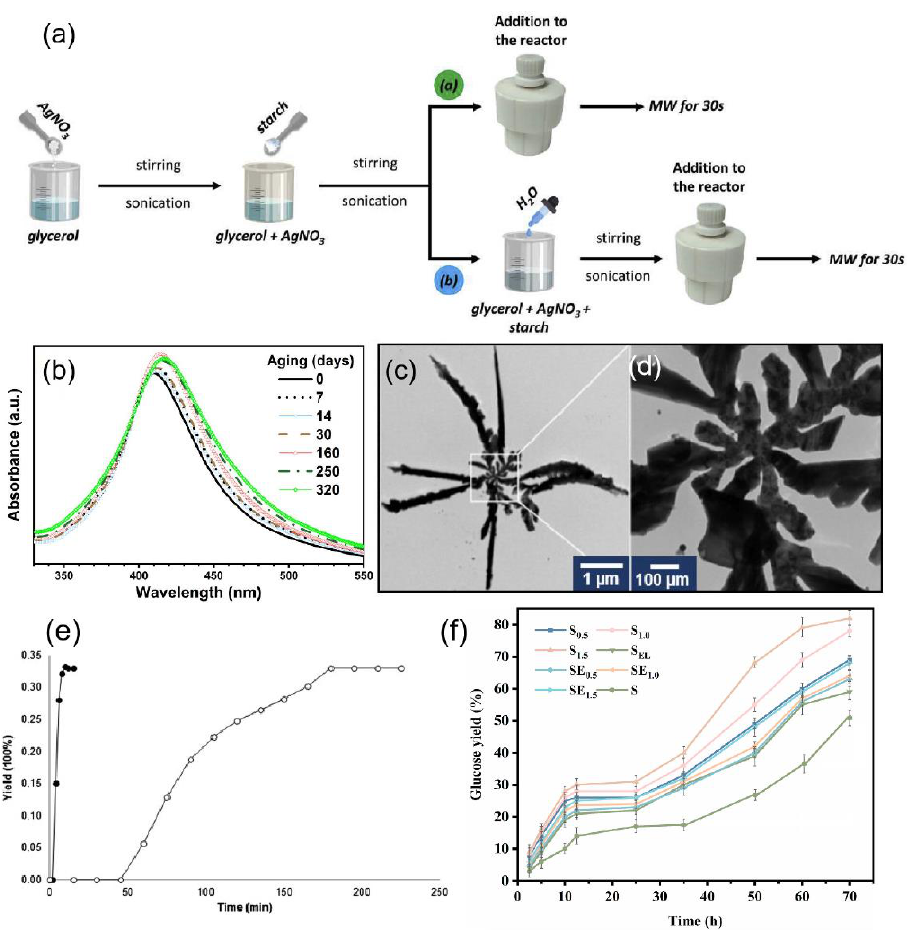
Figure 6. ( a ) Schematic representation for the syntheses of Ag NPs, where the solvent is a. pure glycerol and b. glycerol/water mixtures. MW: microwave. Reprinted with permission from Ref. [101]. Copyright 2021, International Journal of Hydrogen Energy. ( b ) Aging of Ag NPs. Reprinted with permission from Ref. [101]. Copyright 2021, International Journal of Hydrogen Energy. ( c ) TEM image of a typical individual silver nanostar. ( d ) TEM image of the central zone of the nanostar. Reprinted with permission from Ref. [102]. Copyright 2022, International Journal of Molecular Sciences. ( e ) Yields as a function of time for extractions of essential oil from rosemary leaves by microwave hydro-diffusion and gravity (MHG) ( • ) and hydro-distillation ( ). Reprinted with permission from Ref. [103]. Copyright 2013, TrAC (cid:35) Trends in Analytical Chemistry. ( f ) Glucose yields of enzymatic hydrolysis of the cellulose-rich residues obtained from the integrated process. Reprinted with permission from Ref. [105]. Copyright 2022,